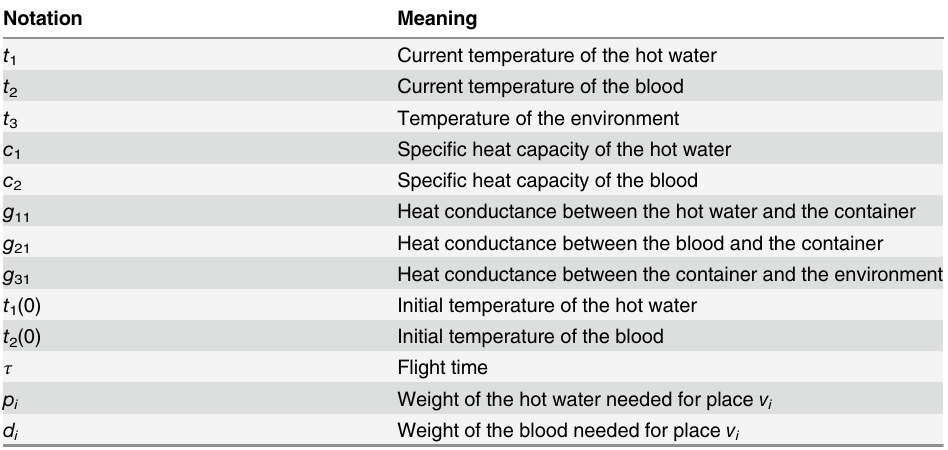
Table 1. Notations used in the Heat Conduction